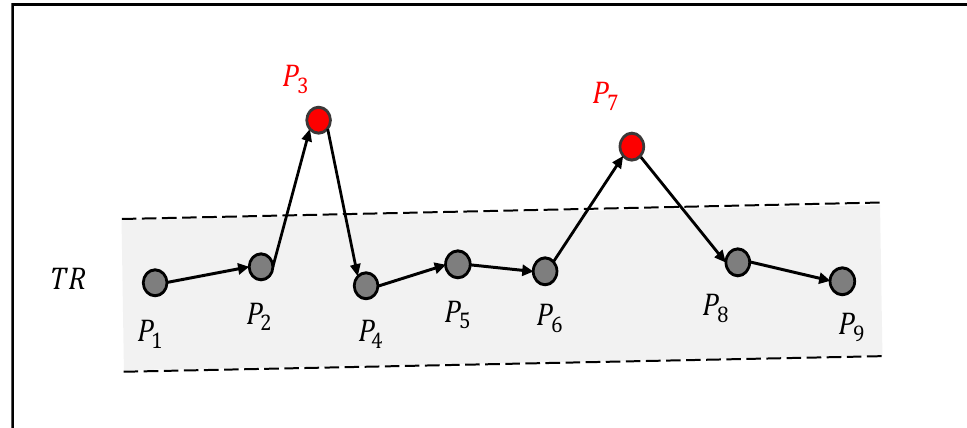
Figure 1. Example of Location Offset Point.